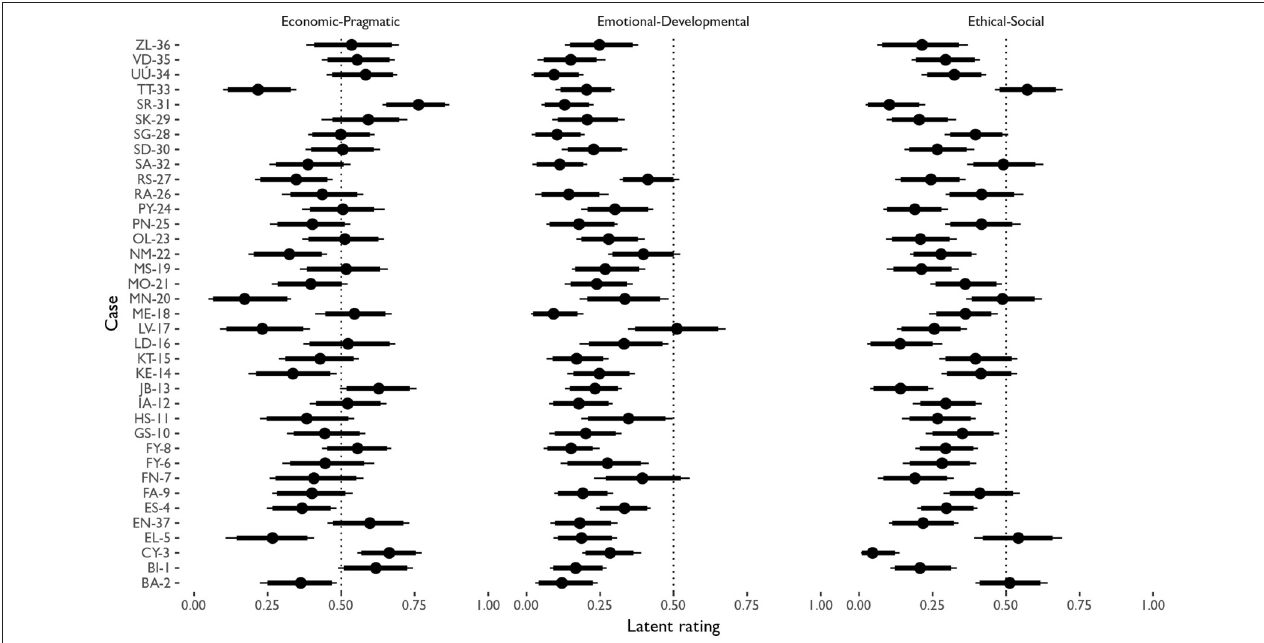
FIGURE 4 | Caterpillar plot showing the mean (dot) and credible intervals (90 and 95 percent with thick and thin lines, respectively) of the posterior densities of θ . The dots represent the point estimate expected value of that specific case and axis of values in the latent configuration of values. The lines represent the credible intervals at standard margins of